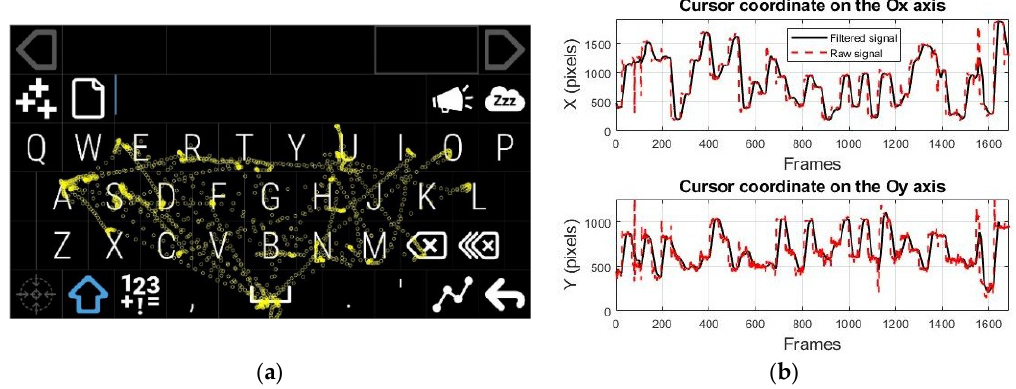
Figure 15. ( a ) Cursor movement tracking on the virtual keyboard developed by OptiKey [56] and ( b ) signals provided by the PDA on both axes of the coordinate system during typing a sentence.